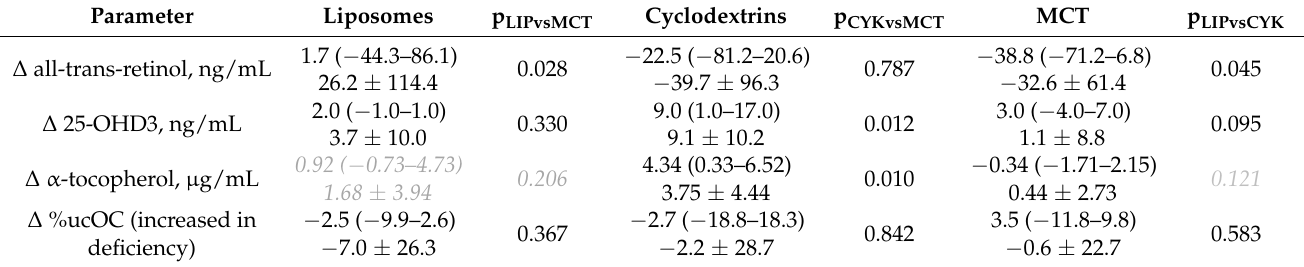
Table 5. The primary outcome. Changes in the concentrations of all-trans-retinol, 25-hydroxyvitamin D3 (25-OHD3), α -tocopherol, and the percentage of undercarboxylated osteocalcin (%ucOC) in the serum of PI CF patients supplemented for three months with vitamins in cyclodextrin, liposomal, or MCT forms. Liposomal vitamin E could not be investigated for technical reasons. Medians (1st–3rd quartile) are presented along with means ± standard deviation and two-sided p values for the comparisons using the Welch test. Studied doses of vitamin A and E were lower than that typically used by the patients before inclusion.